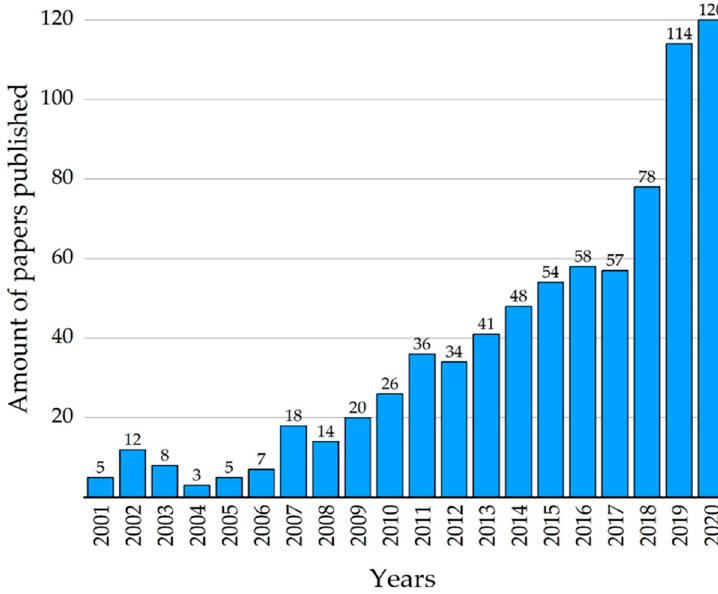
Figure 1. Annual publication volume of ANNs in the field of oil and gas.